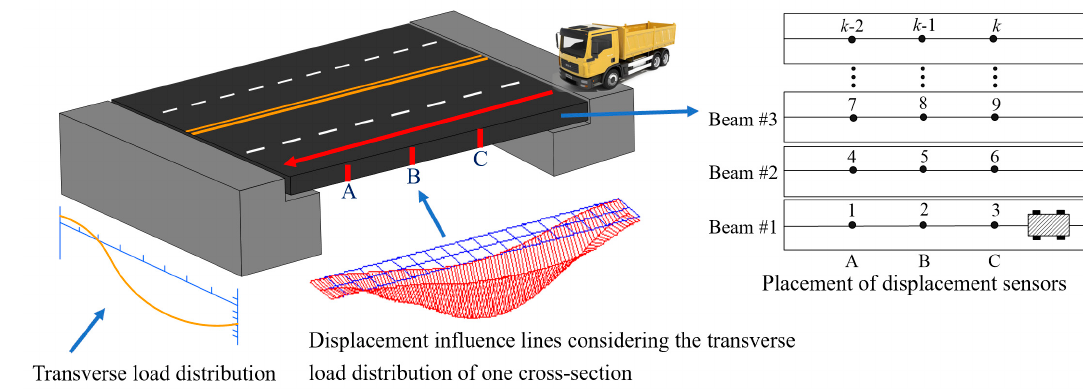
Figure 1. Schematic of the quasi-static load test of a bridge.